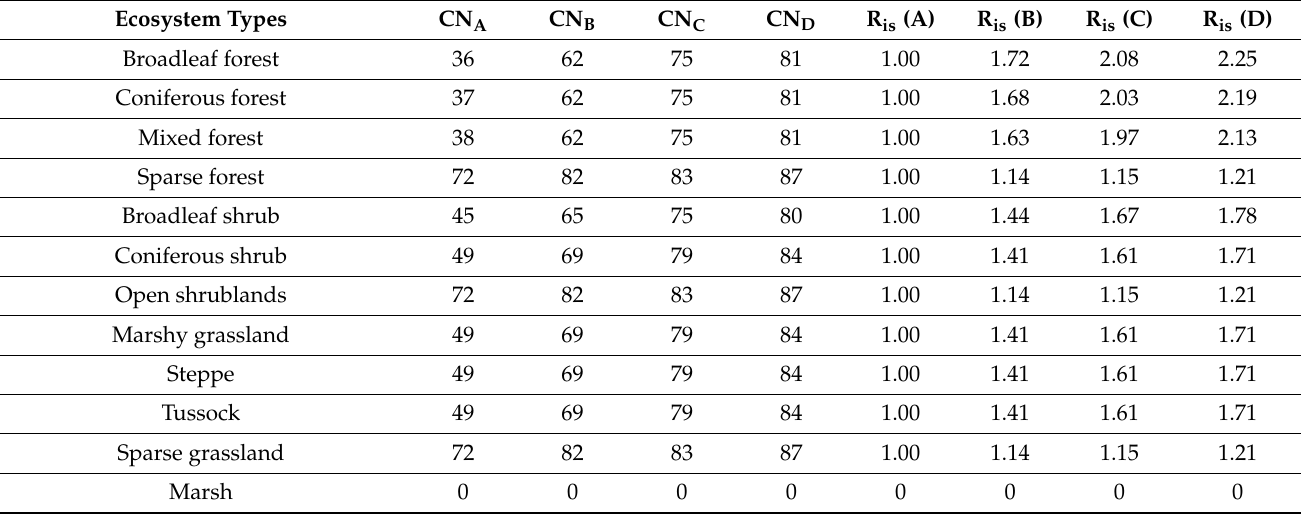
Table 2. CN * of different HSG and runoff index of soil ( R is